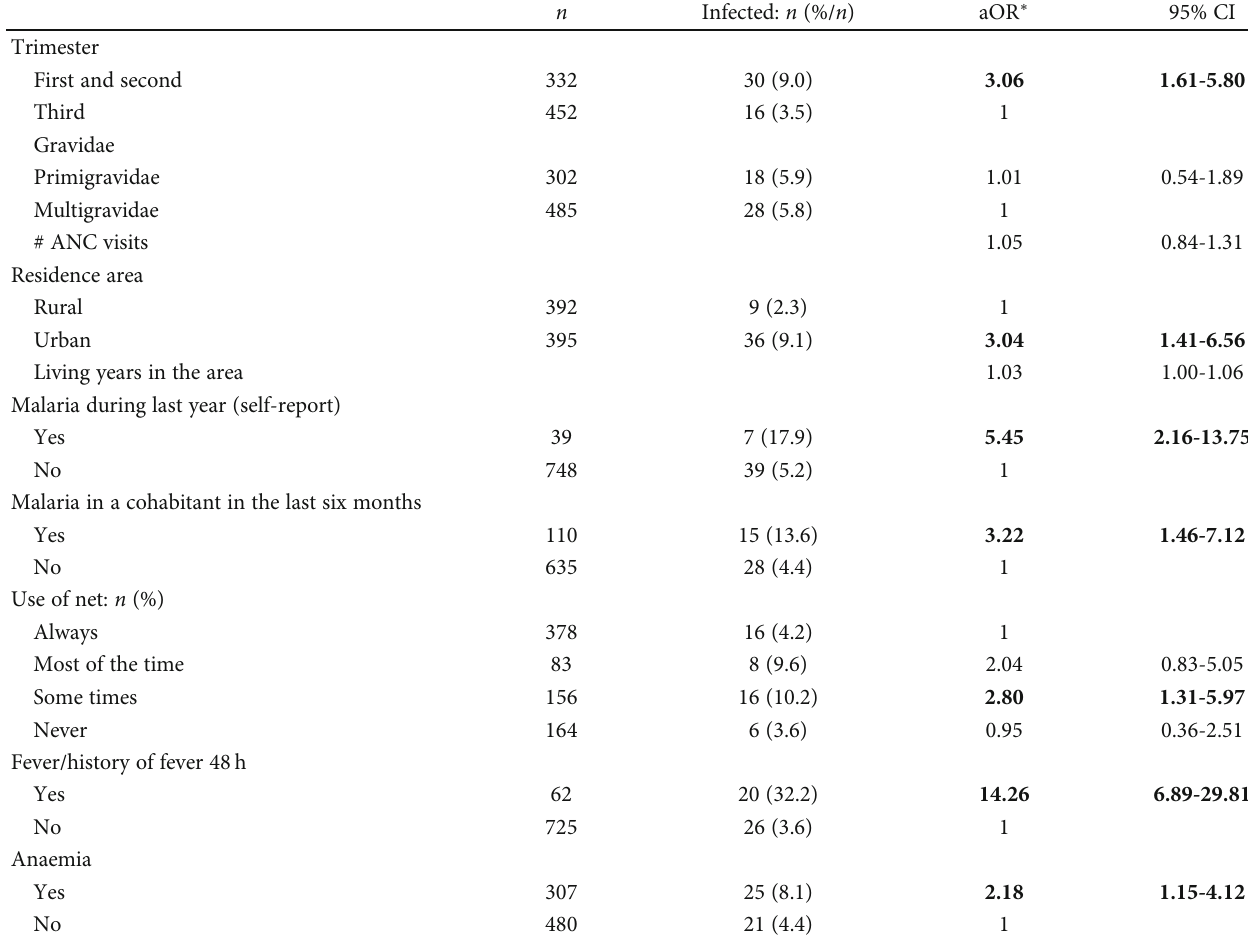
Table 5: Logistic regression analysis of associated factors to Plasmodium spp infection among pregnant